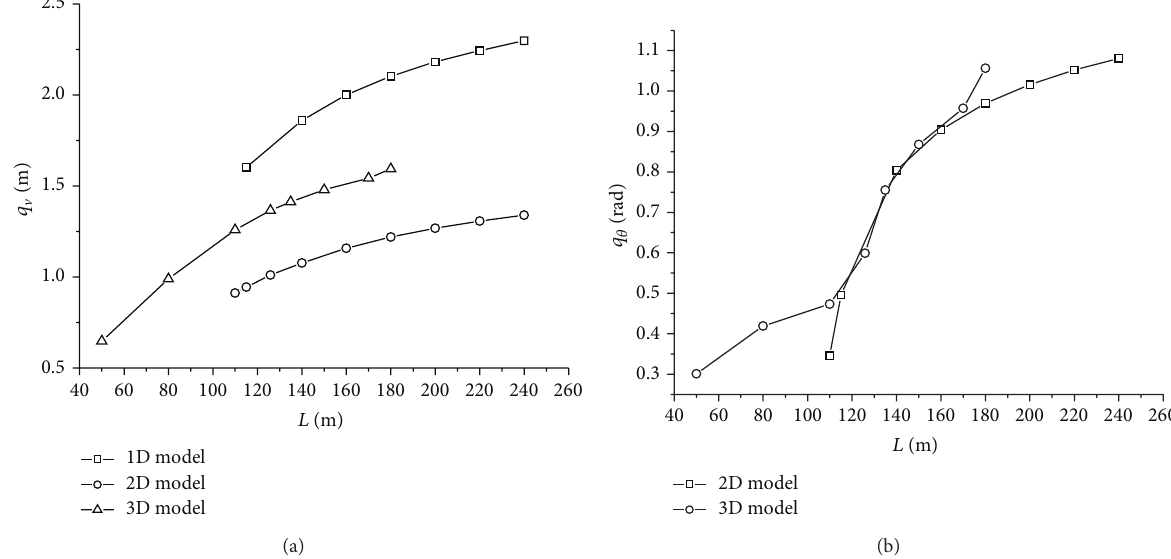
Figure 7: The influence of the span length on the galloping amplitude: (a) vertical amplitude and (b) torsional amplitude.